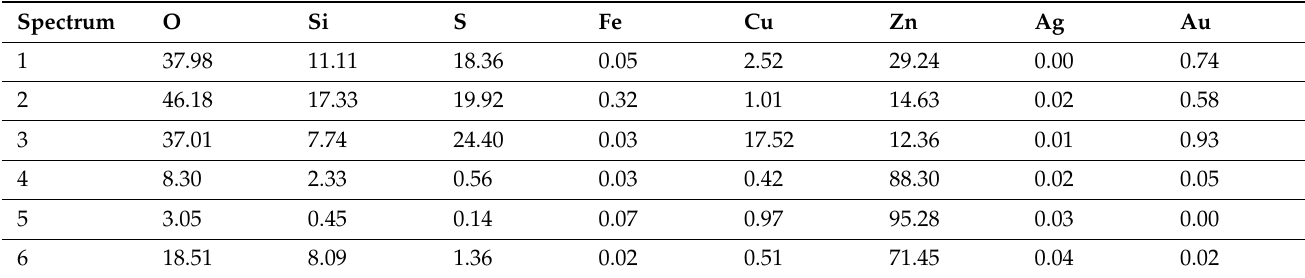
Table 9. Elemental composition of the sediment.